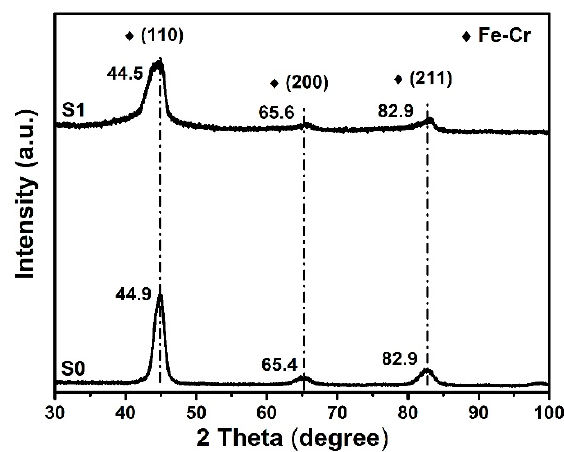
Figure 6. Grazing incidence X-ray diffraction (GIXRD) spectra of samples S0, S1.